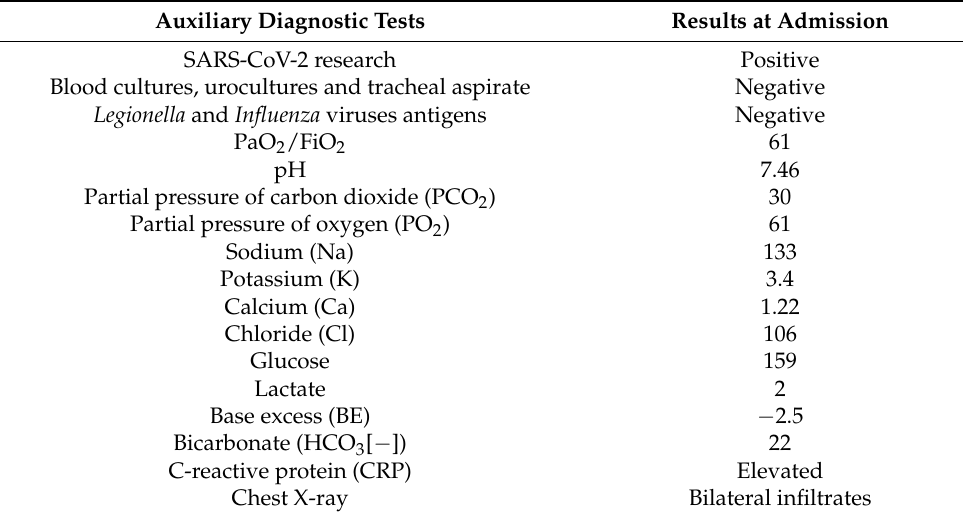
Table 1. Clinical parameters at patient